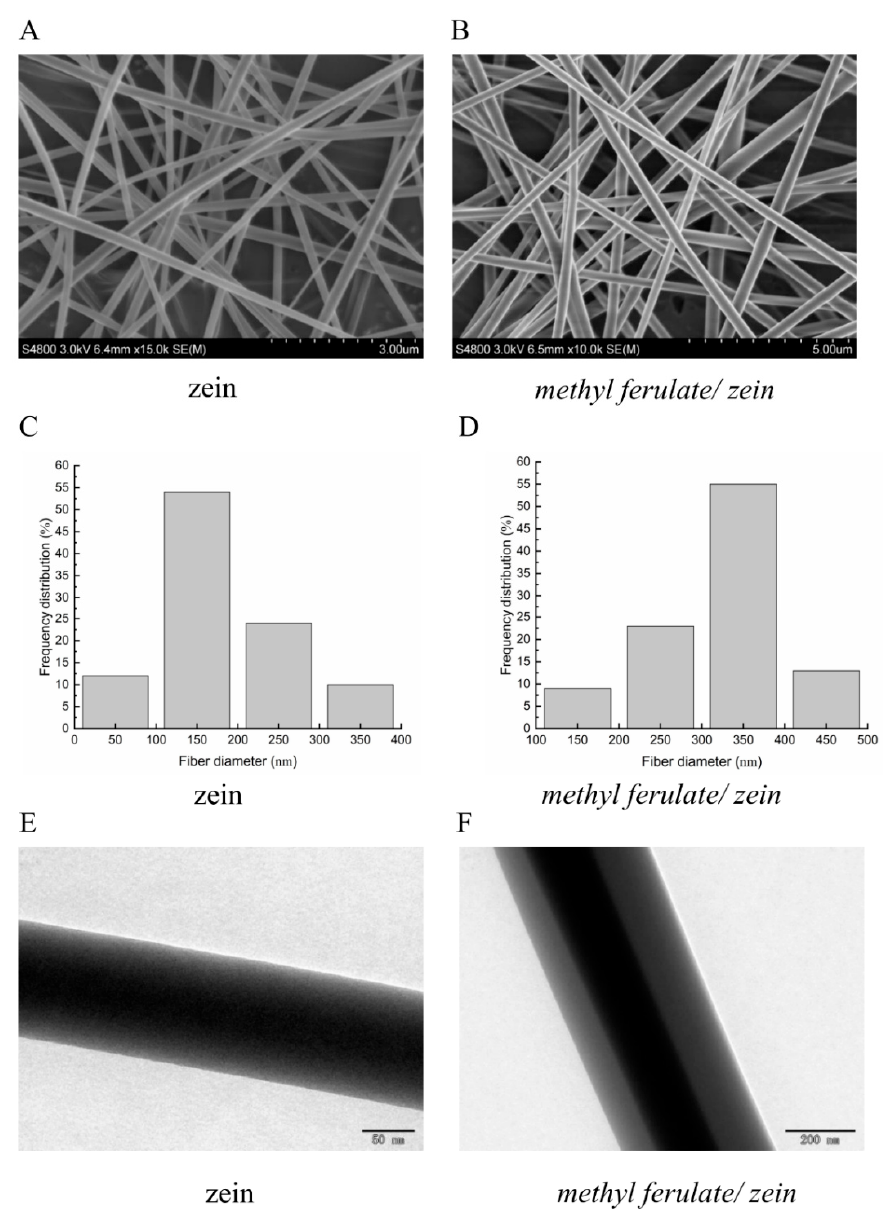
Figure 2. ( A ) SEM images of zein electrospinning fibers. ( B ) SEM images of methyl ferulate/zein elec- trospinning fibers. ( C ) Diameter distribution histogram of zein electrospinning fibers. ( D ) Diameter distribution histogram of methyl ferulate/zein electrospinning fibers. ( E ) TEM images of zein electro- spinning fibers. ( F ) TEM images of methyl ferulate/zein fibers. Table 1. Mechanical properties of fiber